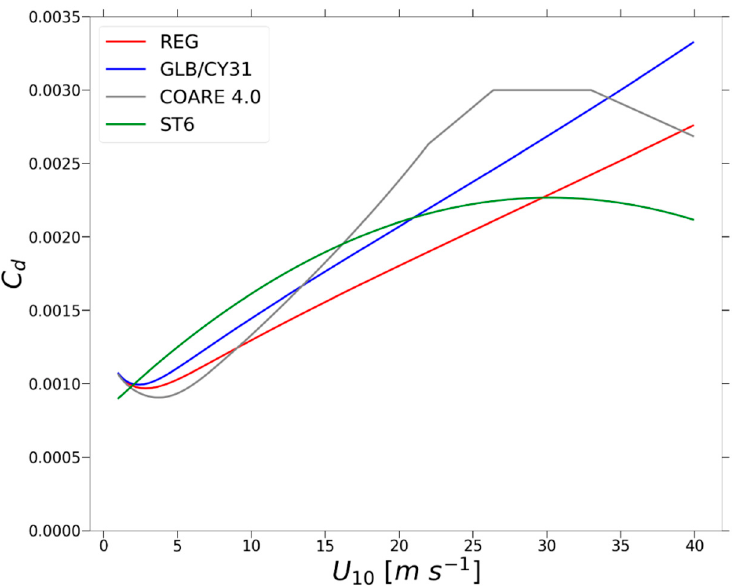
Figure 2. Estimates of the drag coefficient ( C d ) versus wind speed ( U 10 ) for different parameterisations. The red and the blue lines correspond with model configurations (WWIII regional, REG, and global, GLB/CY31) using constant Charnock coefficients ( α ) of 0.011 and 0.018, respectively. The grey line is based on a modified version of the COARE algorithm [23] suitable for Met Office systems, COARE 4.0, where α increases with wind speed up to an upper bound, hereafter it is constant. The green line is based on [80] scheme implemented in ST6 physics.